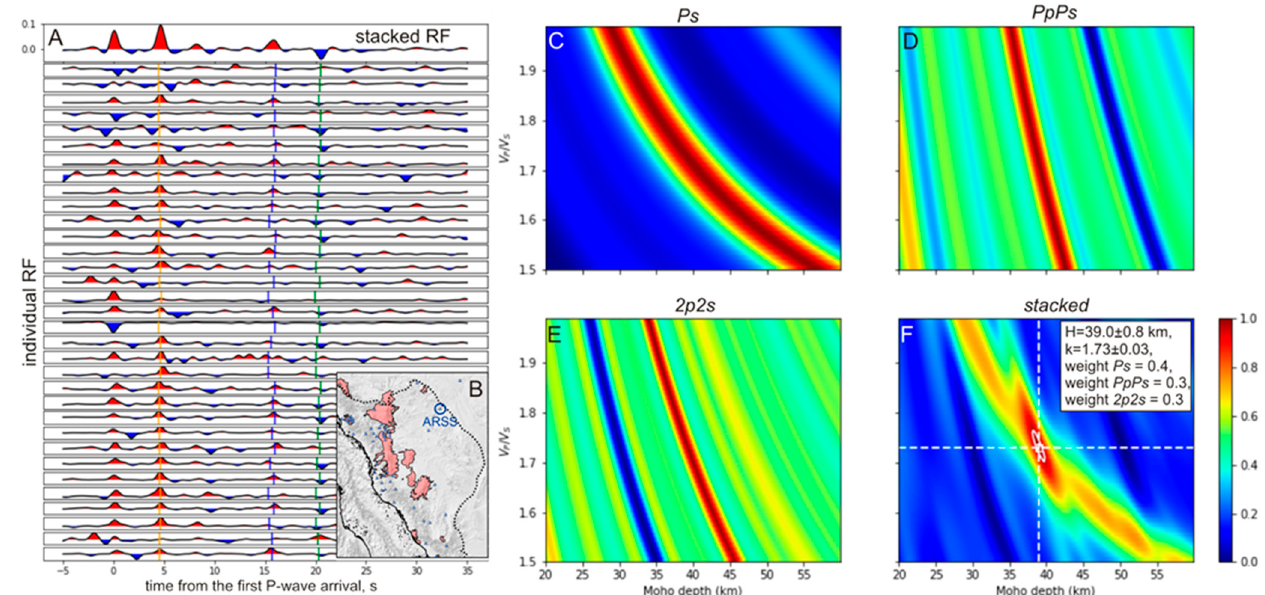
Figure 4. Results of the H-k stacking for the station ARSS located on the Arabian Shield far from the Red Sea coast. ( A ): Individual receiver functions (Q-component). The upper trace is the average of all traces. Red, blue, and green hatches mark the theoretical arrivals of the Ps , PpPs and 2p2s phases, respectively. ( B ). The location of the station on the map. ( C – E ): Grid search results for three individual phases Ps , PpPs and 2p2s . ( F ): Result of stacking of the results for all phases. The white dashed lines mark the best solution. The parameters of stacking and results for H and k determination are shown on the panel F.